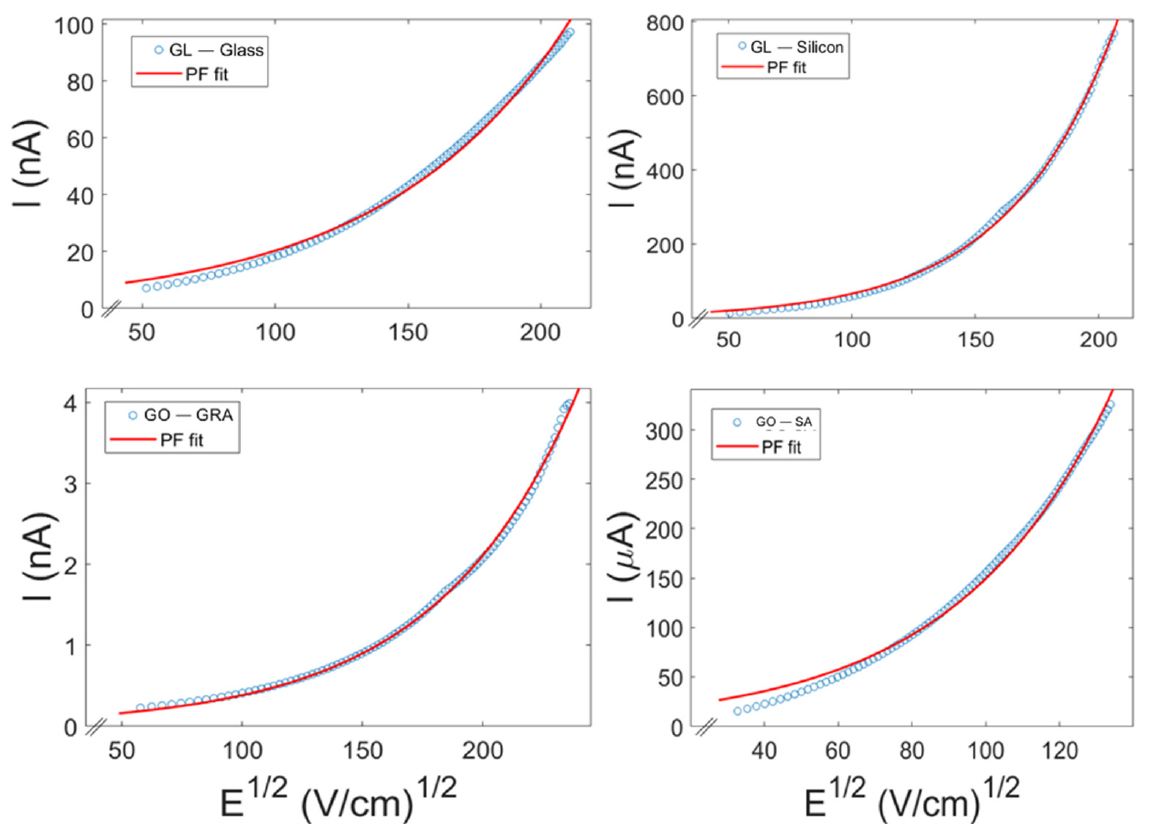
Figure 11. Plots of I vs E 1/2 , where E is the electric field. The curves are fitted by Poole–Frenkel (PF) model.